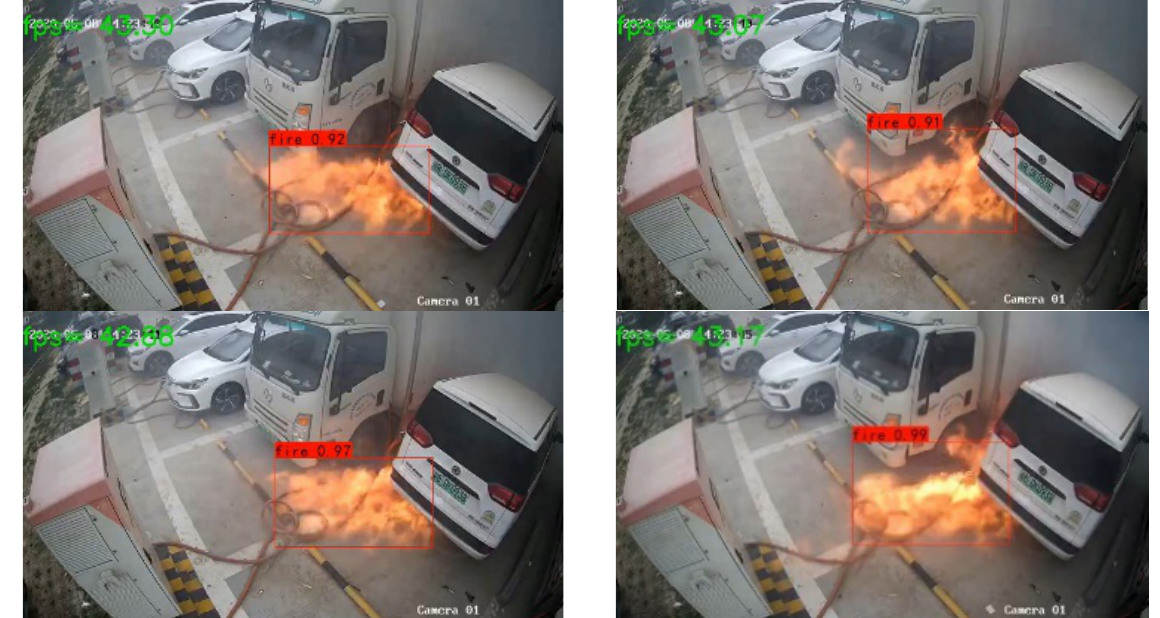
Figure 11. Electric vehicle charging station fire real-time monitoring results.